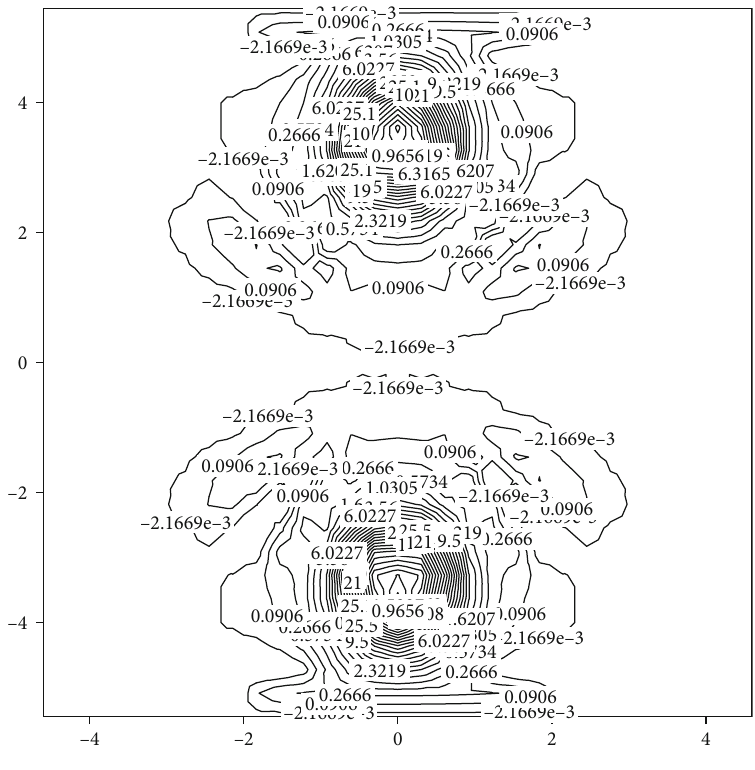
Figure 4: Contours of the V00 PES for Na